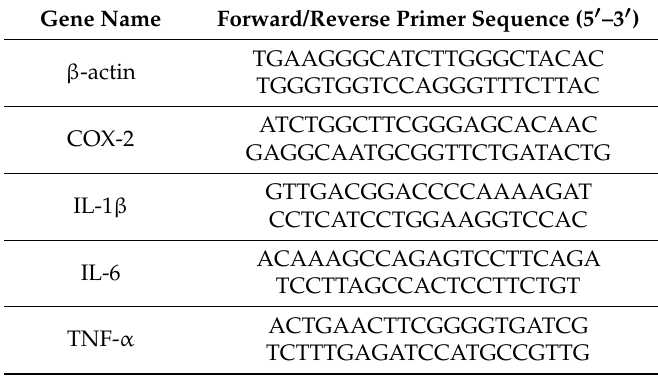
Table 3. Primer sequences used in quantitative real-time polymerase chain reaction (qPCR)